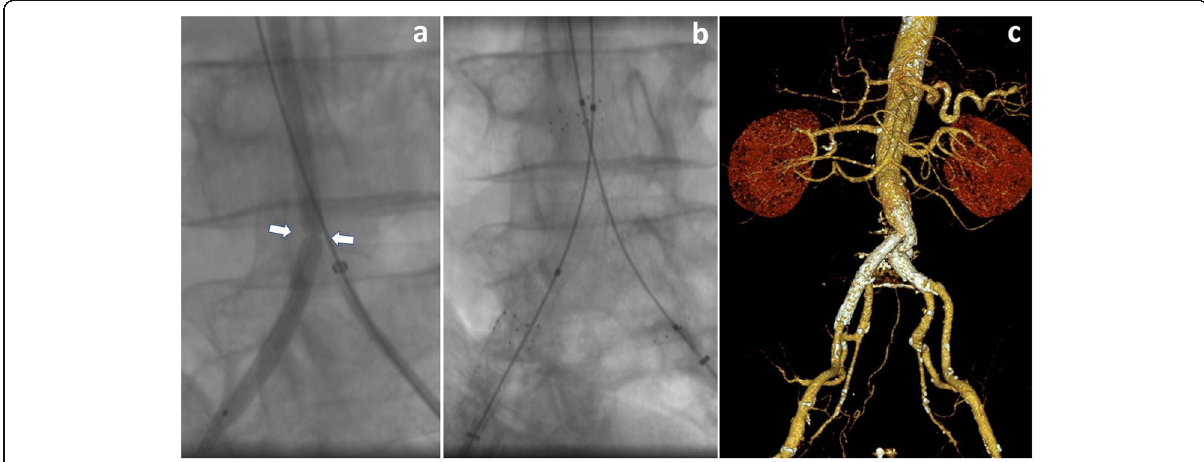
Fig. 3 a Dilation with a low-profile ballon. Note the resistance to expansion in proximity to the passage created by the GoBack needle (arrows). b Deployment of aortoiliac kissing stents. c CT-scan follow up at 1